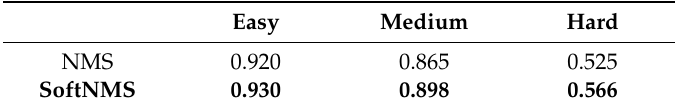
Table 1. Average precision comparison of non-maximum suppression (NMS) and soft non-maximum suppression